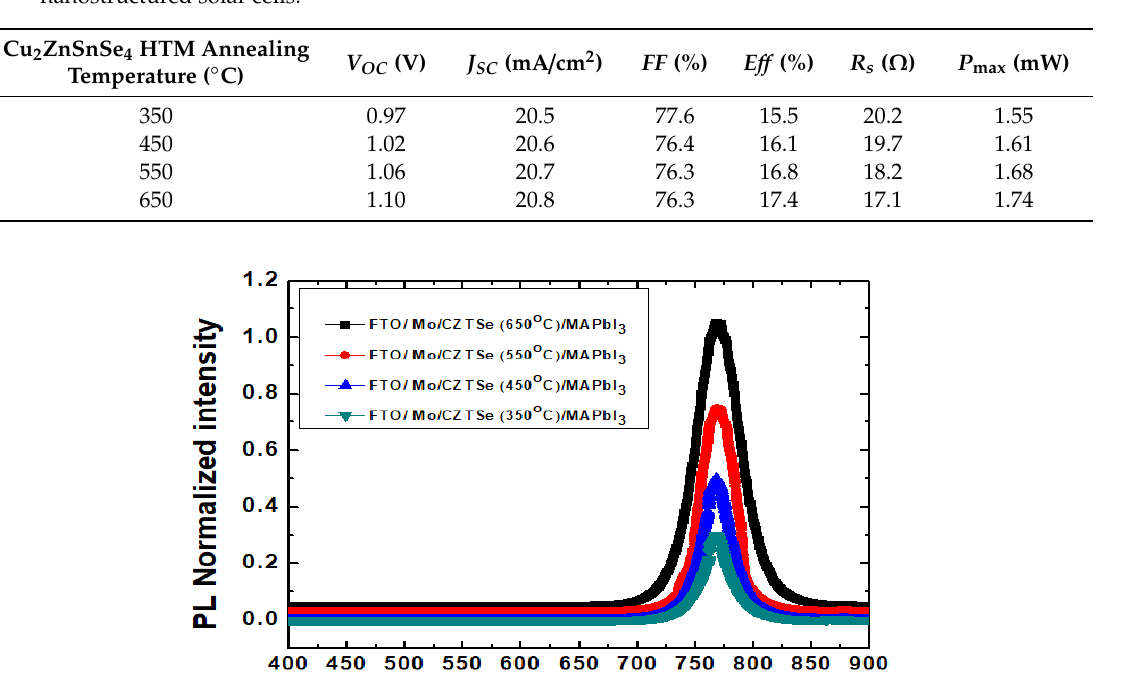
Figure 11. PL spectra of MAPbI 3 perovskite nano-films onCu 2 ZnSnSe 4 /Mo/FTO following the various thermal annealing temperatures.